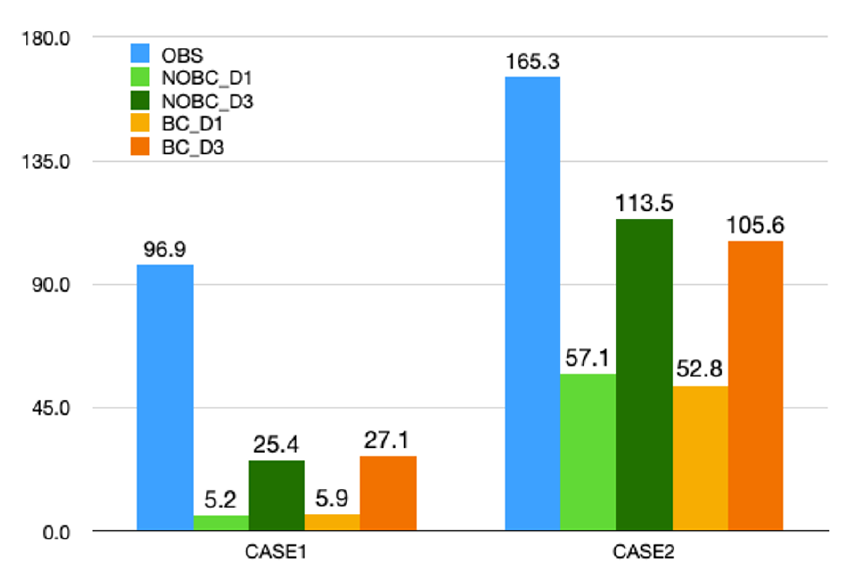
Figure 12. The accumulated heat index averaged for 94 stations derived from observations and the two sets of NOBC and BC